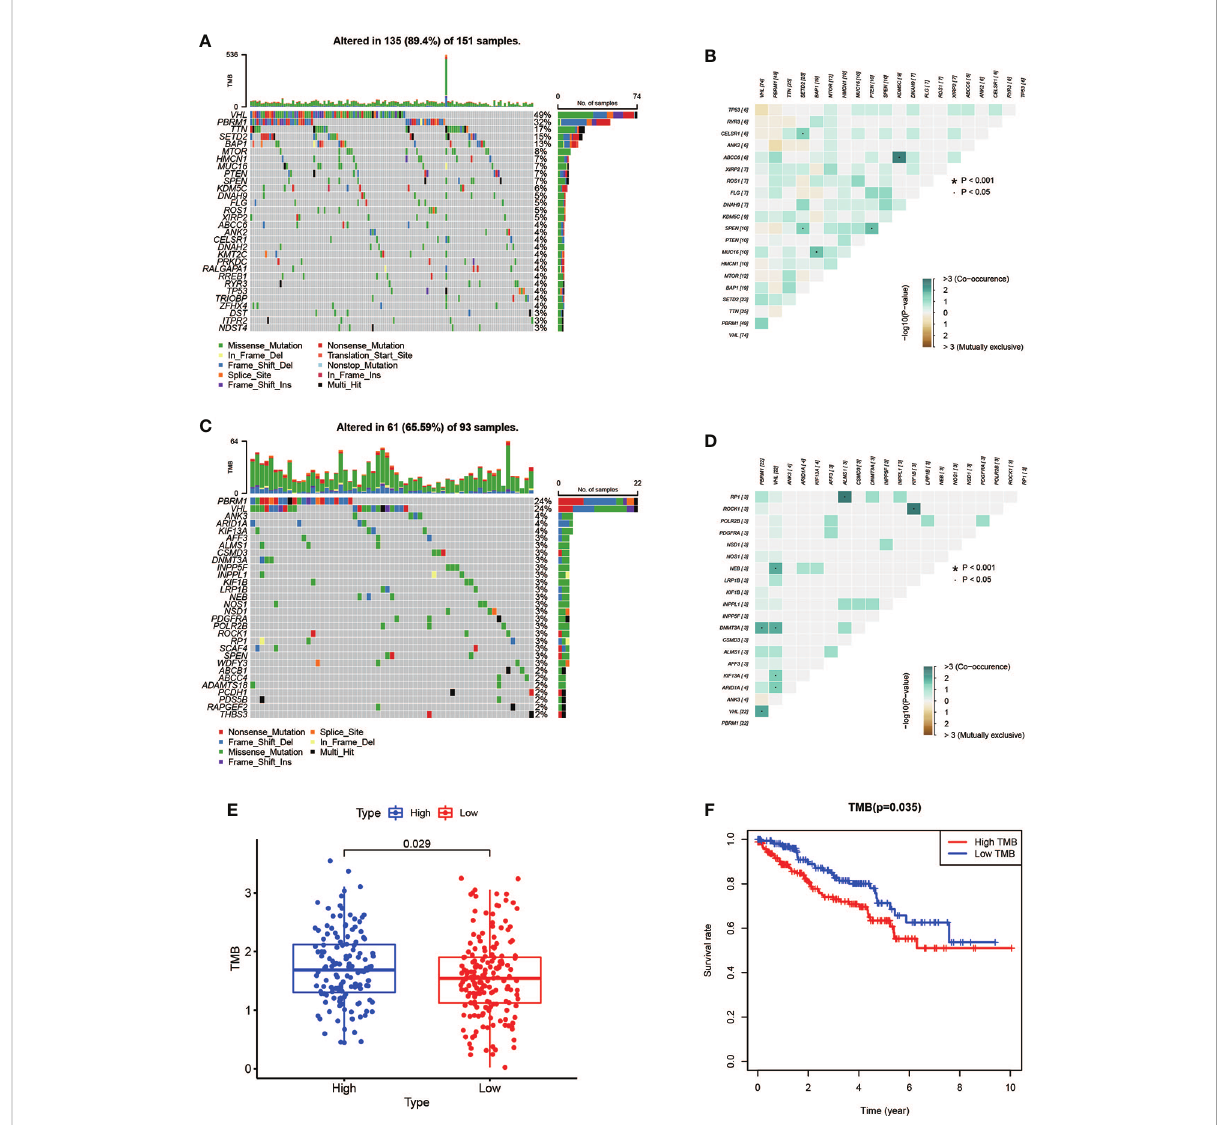
FIGURE 9 Mutation pro fi le and relationship between tumor mutation burden (TMB) and risk score. (A, B) Mutation pro fi le of the high-risk group and interaction among 20 most frequent mutant genes. (C, D) Mutation pro fi le of the low-risk group and interaction among 20 most frequent mutant genes. (E) Relationship between TMB and risk score. (F) Association of TMB and overall survival in KIRC